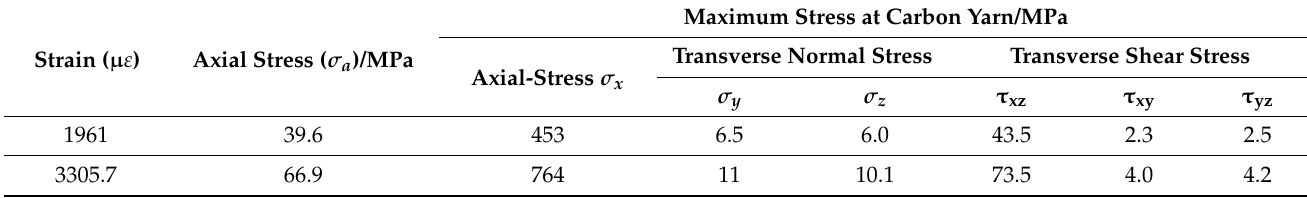
Table 8. Finite element stress predictions for the unit cell for 1961 (µ ɛ ) and 3305 (µ ɛ ).